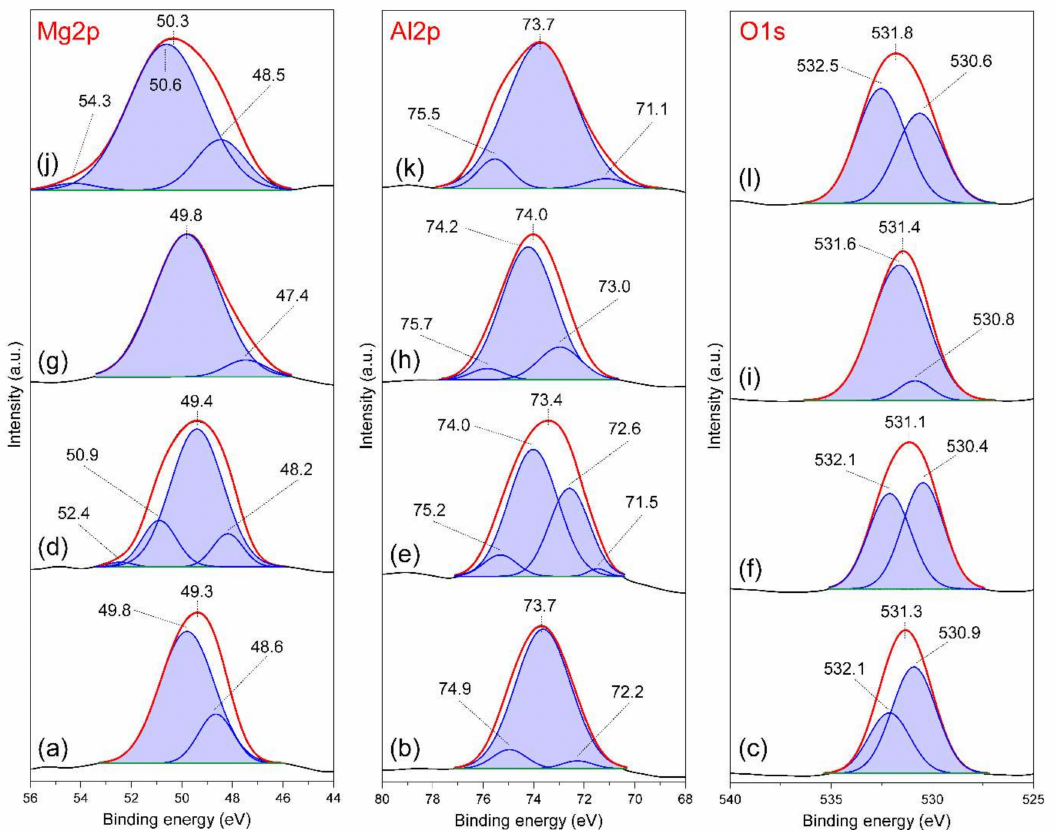
Figure 12. XPS Mg2s, Al2p and O1s spectra of: ( a – c ) Mg-Al-Cl-2 sample (pH 7), ( d – f ) FB1-treated Mg-Al-Cl-2 sample (pH 7), ( g – i ) Mg-Al-Cl-2 sample (pH 5), and ( j – l ) FB1-treated Mg-Al-Cl-2 sample (pH